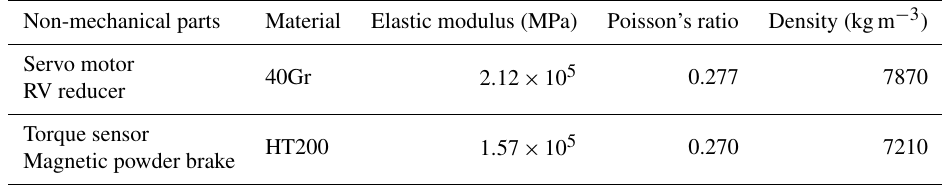
Table 1. Material parameters of non-mechanical parts of the transmission system.